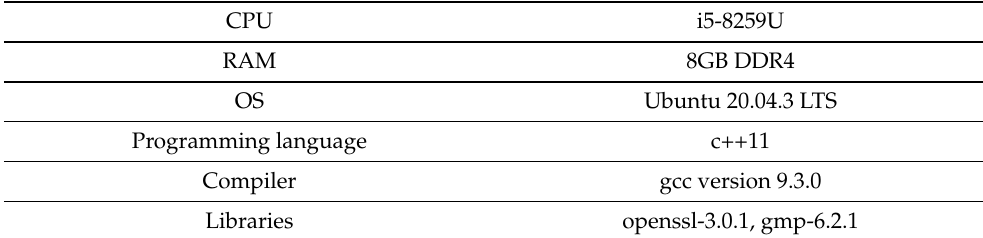
Table 2. Configurations of experiment on X86